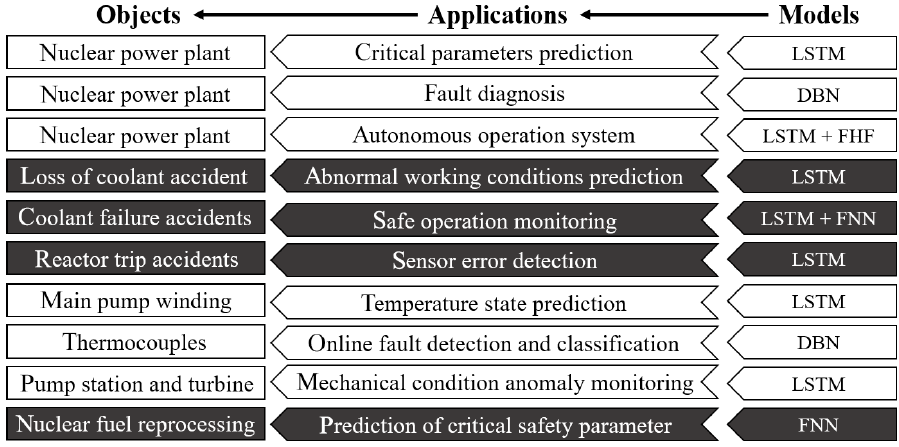
Fig. 8 Sensor sequence signal data processing based on deep learning in the nuclear